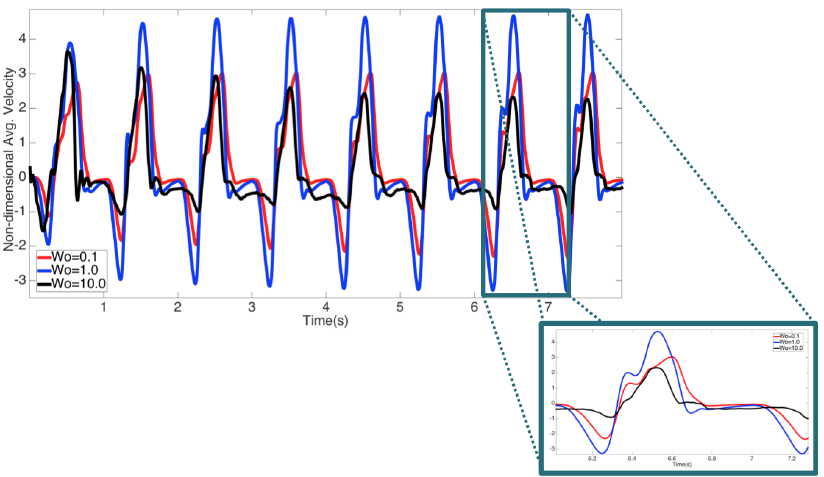
Fig. 10: The non-dimensional spatially-averaged velocity computed across a cross-section of the top of the race-track geometry vs non-dimensional time for D = 100 . 0 , e.g., the ‘peristaltic’ regime, for W o = { 0 . 1 , 1 . 0 , 10 . 0 } . The zoomed in portion illustrates the resulting wave-form.